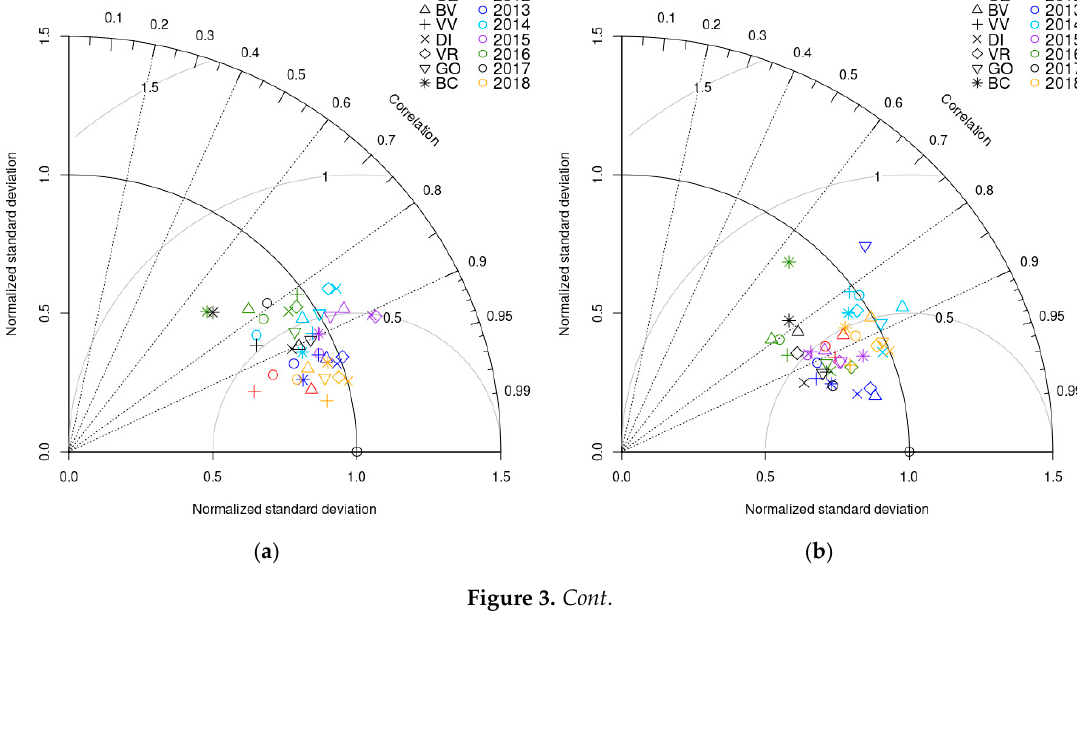
related to the impact of plant development on orchard micrometeorological conditions and air temperature variation in the height of fruit tree crowns, where air temperature sensors are typically installed. Intensive plant development can cause significant variation in canopy air temperature with Figure 2. RMSE and BIAS of daily air temperature for selected locations during MAM 2012–2018. respect to outside of the plant canopy, while in the case of the formed canopy, this variation is negligible. Depending on the variety, intensive apple leaf development took place at the end of March and during April, while in May, the crown was commonly closed, which explains the increase in RMS difference.